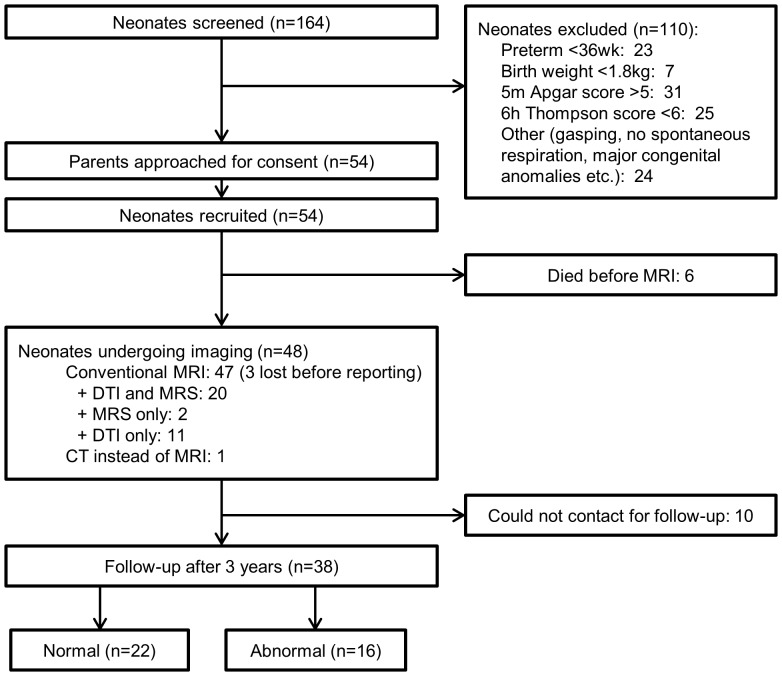
Study flow chart.